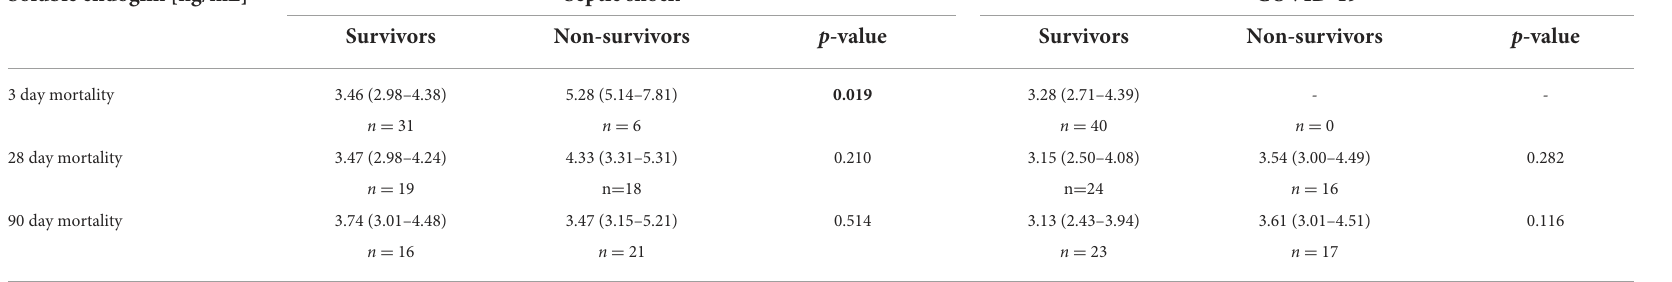
TABLE 3 Levels of sEng of survived and deceased patients 3, 28, and 90 days after ICU admission. Soluble endoglin [ng/mL]